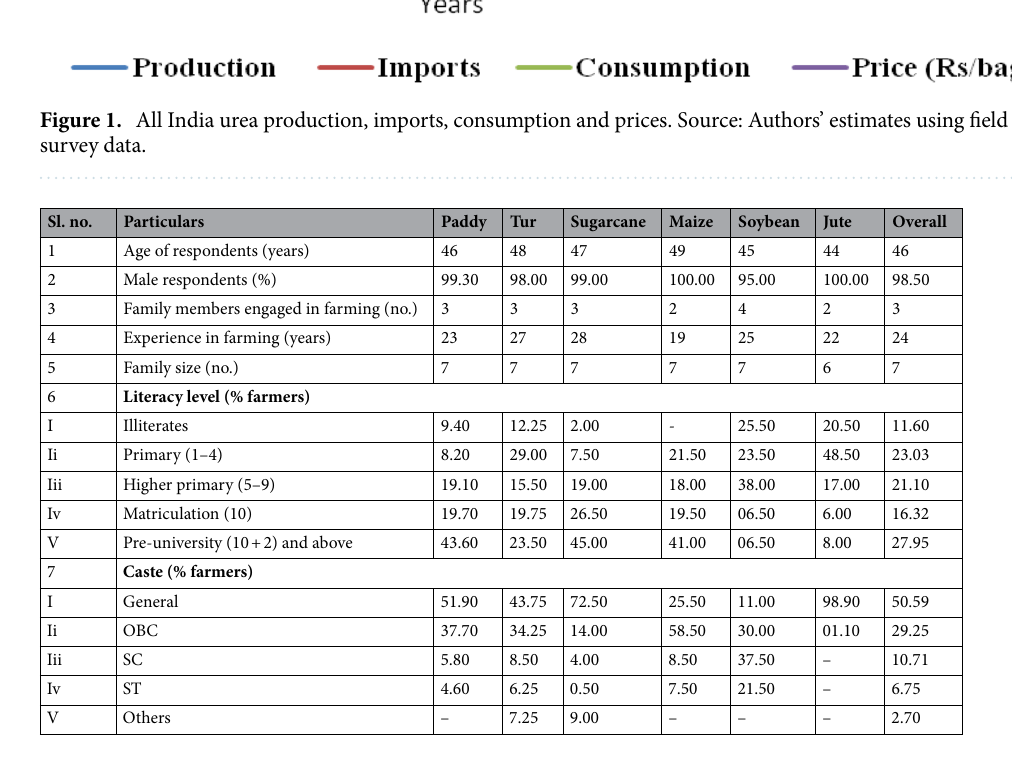
Table 3. Crop- wise socio-economic characteristics of the sample households. Source: Authors’ estimates using field survey data. Selected study sates.